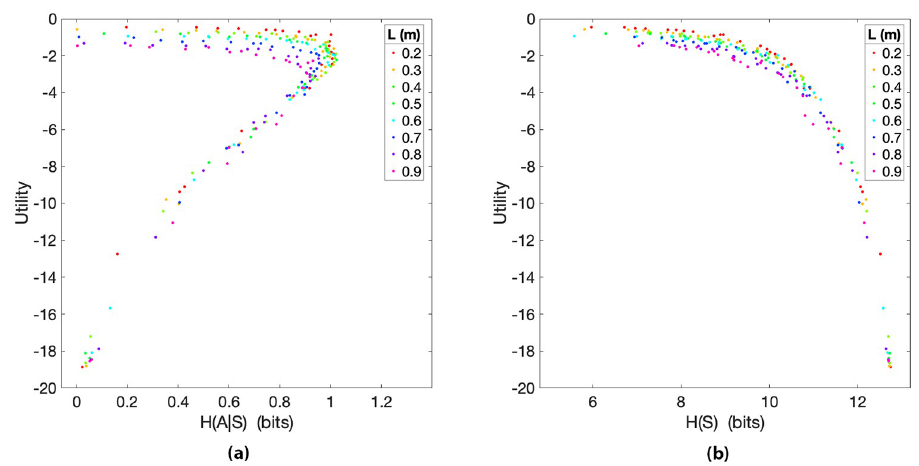
Fig 11. Utility U j of simulations j plotted as a function of H ( A j | S j ) ((a)) and H ( S j ) ((b)) for all artificial controllers and pendulum lengths L . These can be compared to Figs 2A and 4A respectively. No observation and transition noise is employed here (i.e., s O ¼ s O ¼ s T ¼ s T ¼ 0 ). (a) Spearman correlation ρ = 0.67 ( p = 0.334, not significant, due to _ y _ y y y the marked non-monotonicity of the data). (b) ρ = − 0.96 ( p <